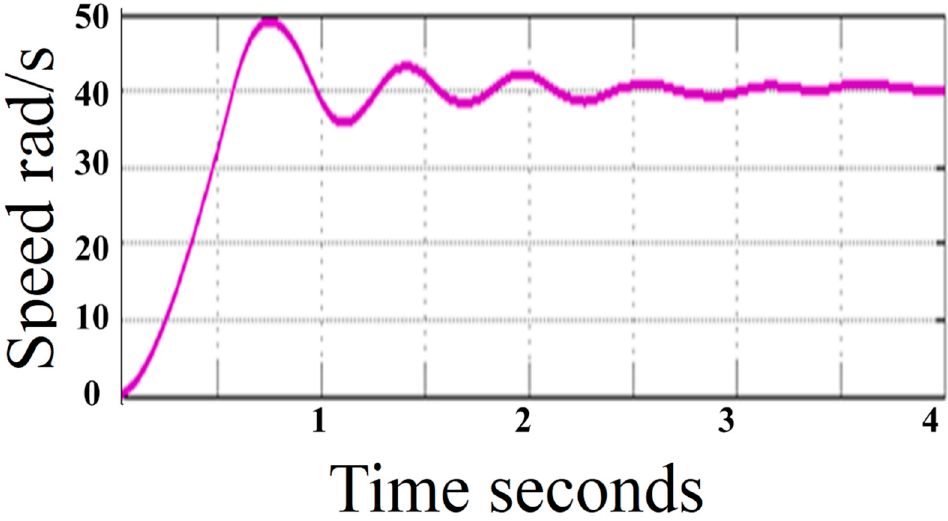
Figure 19. Simulation of the best result obtained in the experimentation with GT2FDE with a noise of 0.7 in the FLC.